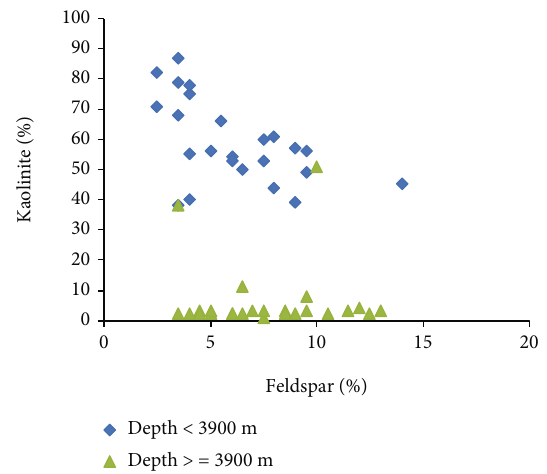
Figure 18: The plot of kaolinite content versus feldspar content for the sandstones of E 2